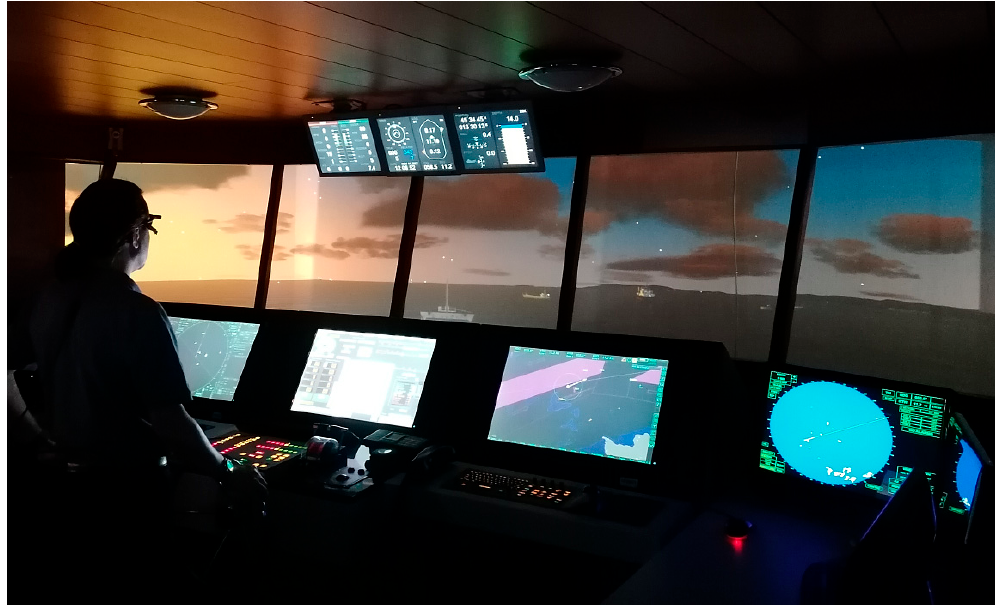
Figure 1. Full mission simulator: Experienced participant during collision avoidance in the traffic separation zone wearing pupil-diameter sensor and wrist multi-sensor.